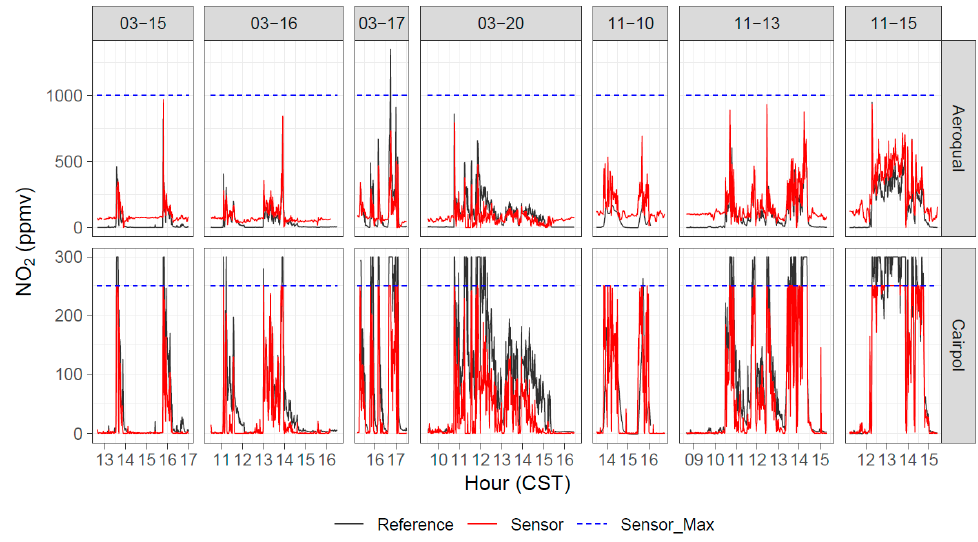
Figure 11. Timeseries of reference, Aeroqual, and Cairpol NO 2 measurements during seven days of Tallgrass Prairie prescribed burn experiments in 2017.